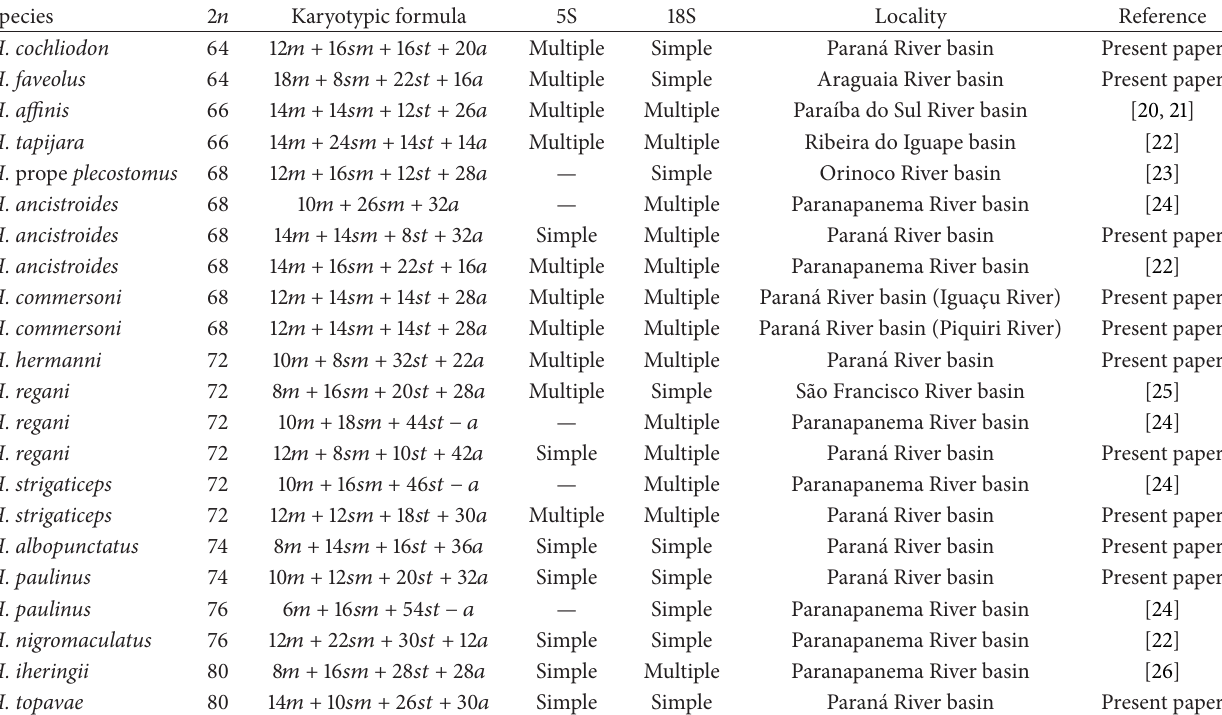
Table 2: Available data regarding 5S/18SrDNA distribution in Hypostomus